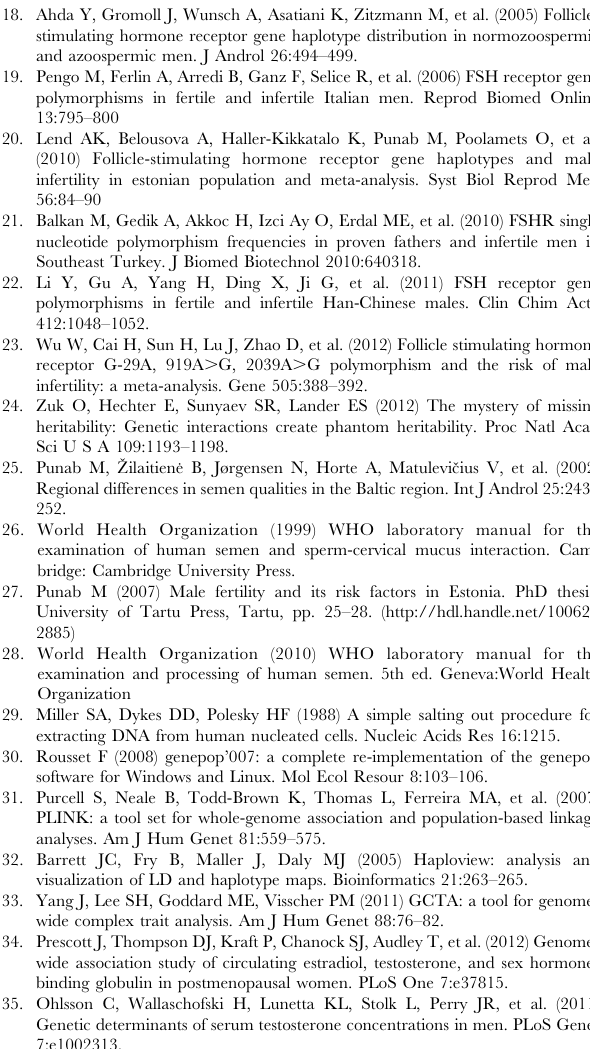
Table S3 Marker-trait association analysis and clinical param- eters of the subgroup of Estonian oligozoospermic idiopathic infertility study sample defined according to the World Health Organization 2010 criteria (sperm count below 39x10 6 /ejaculate; n =408). Parameter data is provided for the subgroups of patients stratified based on their FSHR -29G/A, FSHR Asn680Ser and FSHB -211G/T